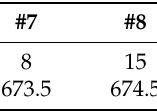
Table 3. Ratio [ C ] / [ Mn ] and position of D peak for all samples.